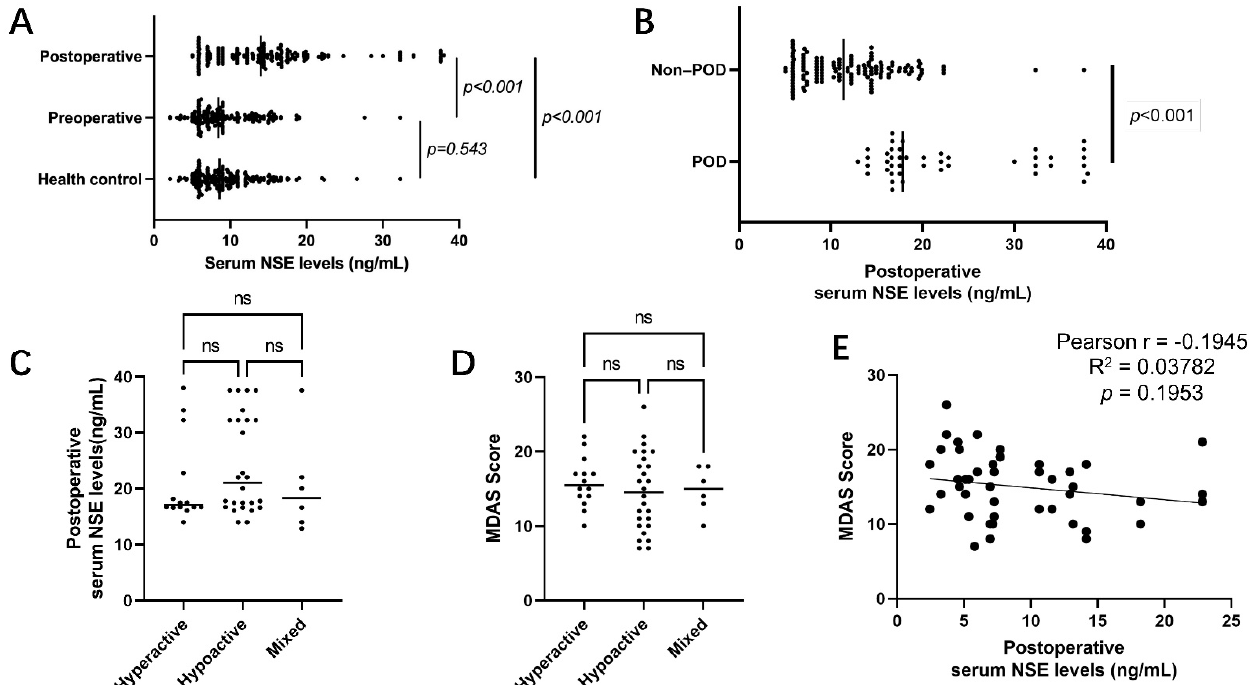
Figure 1. Comparisons of serum NSE levels between the healthy controls and the patients ( A ), between patients with POD and those without POD ( B ), and among patients with different types of delirium ( C ). There was no clear correlation between MDAS scores or the type of delirium and postoperative serum NSE levels ( D , E ). ns: no significance.